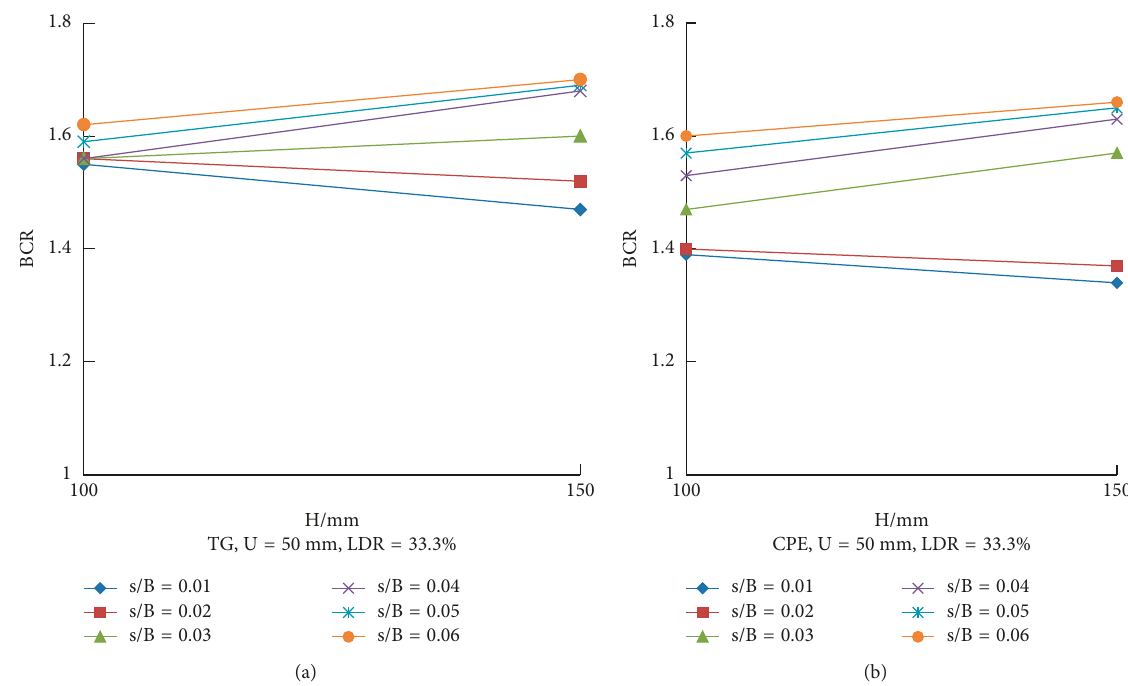
Figure 11: The relationship between BCR and H : (a) TG geobelt ( U